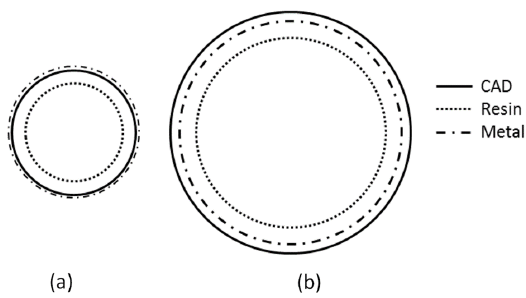
Figure 10. Geometry changes occurring in the manufacturing steps (CAD-Resin-Metal)of the smaller holes [d1 variation – (a)] and larger holes [d2 variation (b]) in the cellular structure.